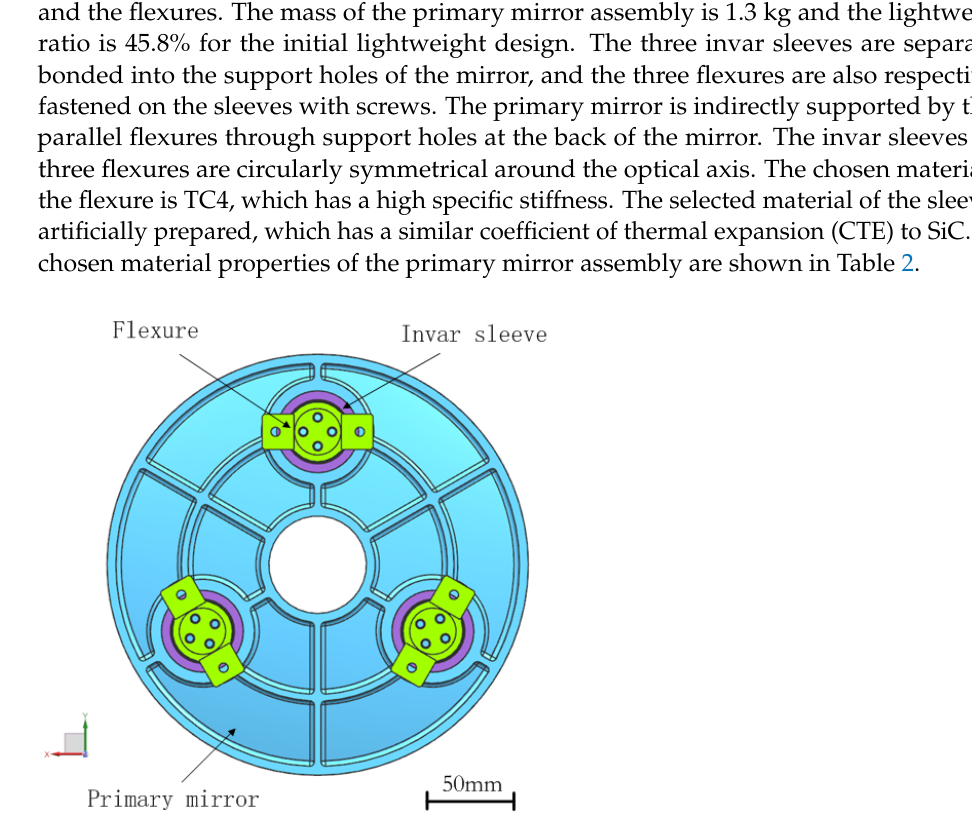
Figure 2. Schematic of the primary mirror assembly. Table 2. Material properties of the mirror